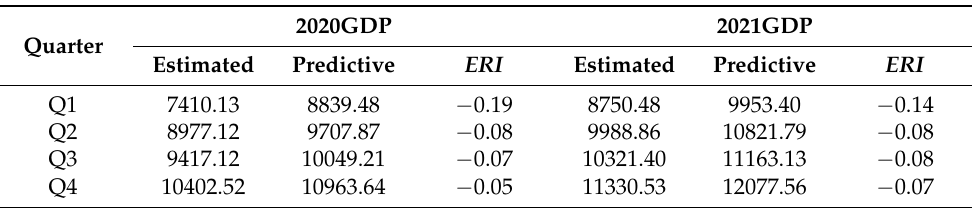
Table 3. Estimated GDP, predicted GDP, and corresponding economic recovery intensity ( ERI ) in Hebei Province for each quarter of 2020 and